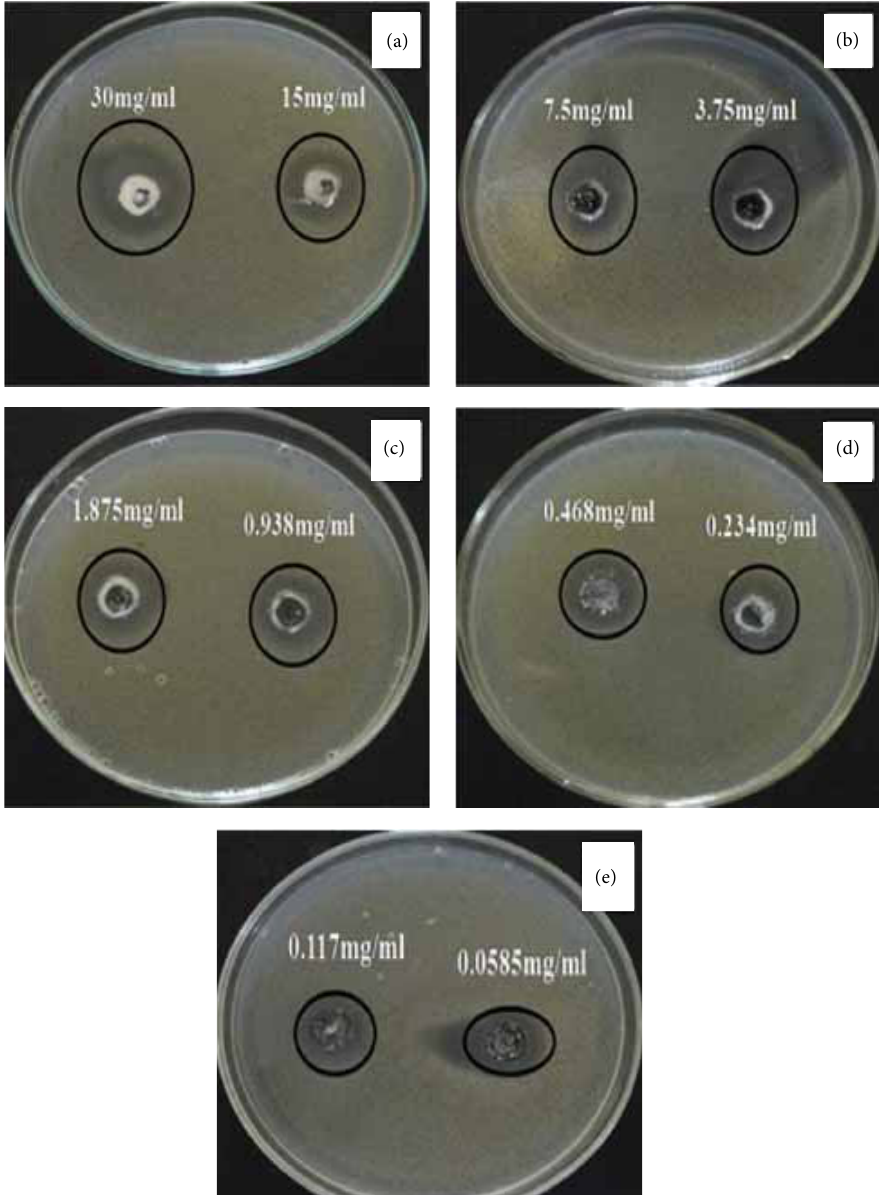
Figure 17: The antimicrobial activity of zinc oxide nanotubes against Escherichia coli using disc diffusion method. ((a), (b), (c), (d), and (e)) Different concentrations of the synthesized